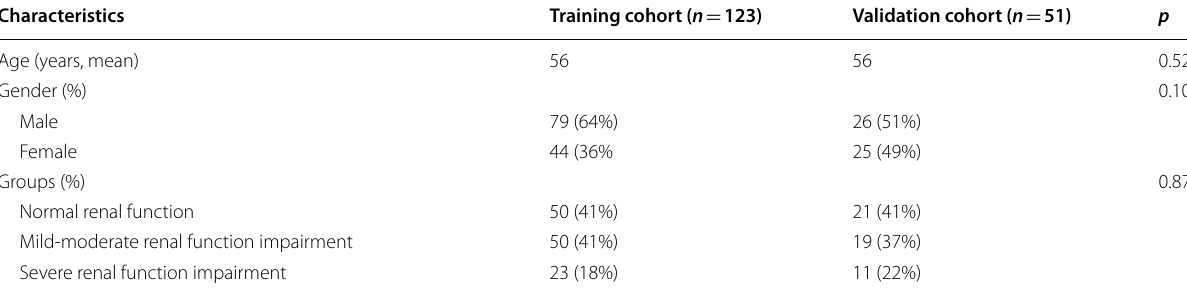
No significant difference of clinical characteristics was existed between training and validation cohorts